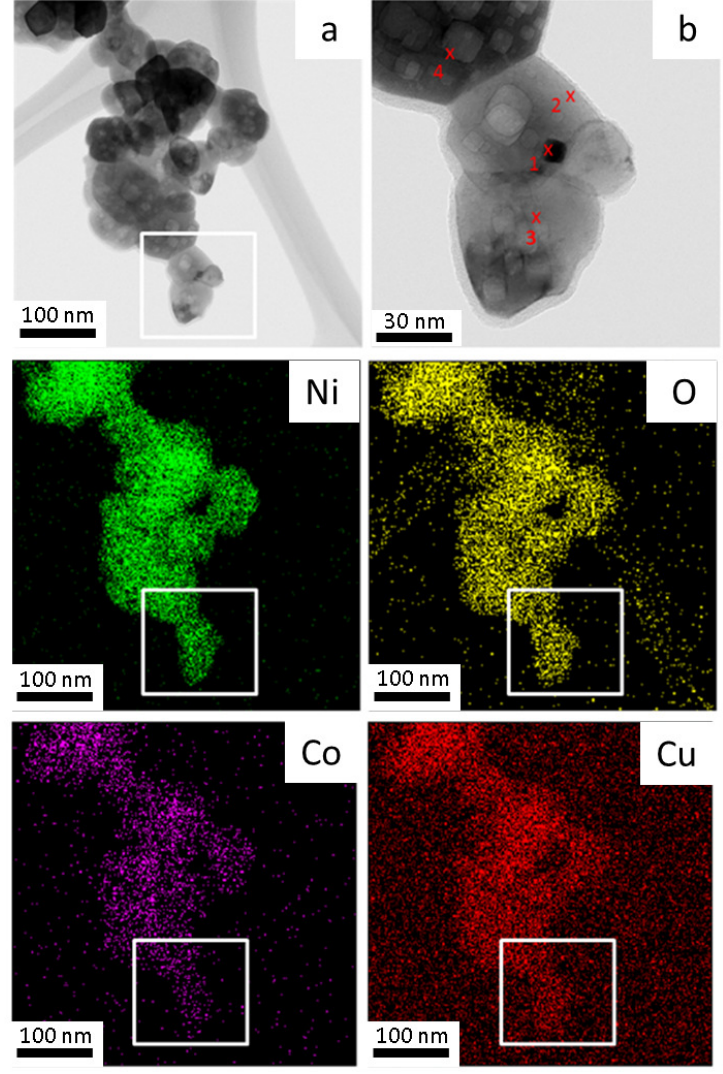
Figure 5. TEM bright-field image and elemental mapping of 10Cu–oxide nanoparticles (thermal decomposition at 500 ◦ C) ( a ) metallic nanoparticles aggregate with the corresponding elemental EDS mapping shown at the bottom. The boxed area enlarged in ( b ) marks the positions of four- point analysis.